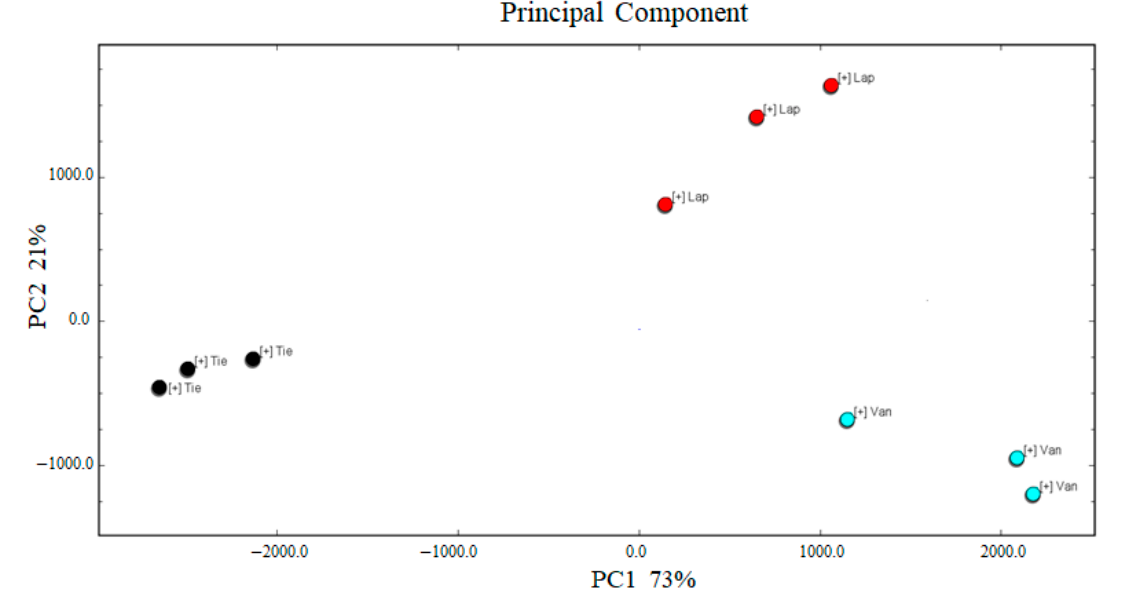
Figure 4. The scores plot of PCA analysis in cherry fruits from three cultivars.